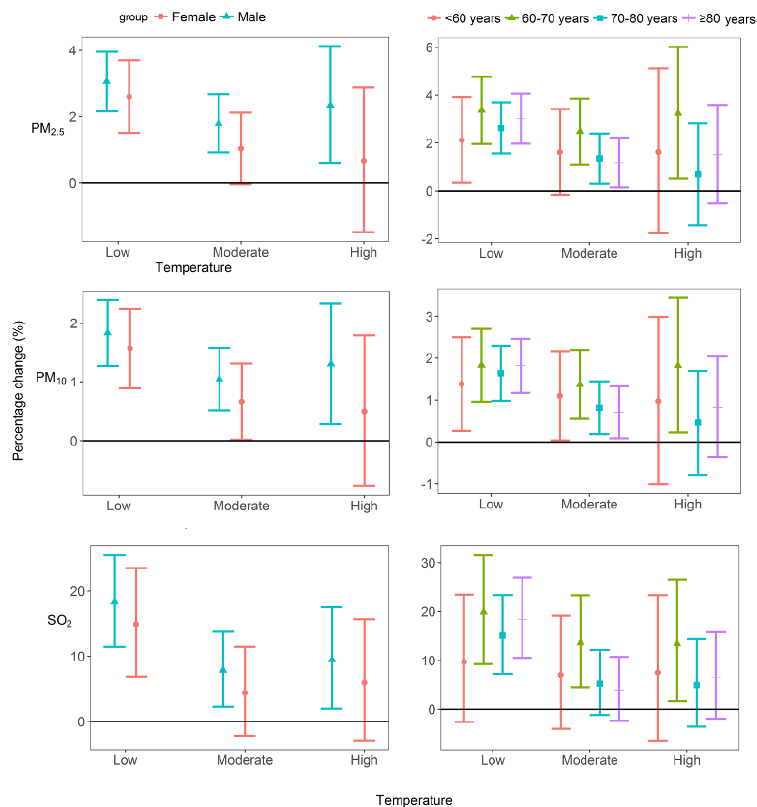
Figure 3. Associations between PM 2.5 /PM 10 /SO₂ concentrations and COPD HAs in low, moderate and high temperature level by age and gender. The percentage change of daily COPD HAs associated with a 10 μg/m³ increase in PM 2.5 , PM 10 and SO₂ concentrations. Table 3. Attributable fraction and number (and 95% confidence interval) of COPD hospital admissions due to PM 2.5 , PM 10 and SO 2 by temperature levels.